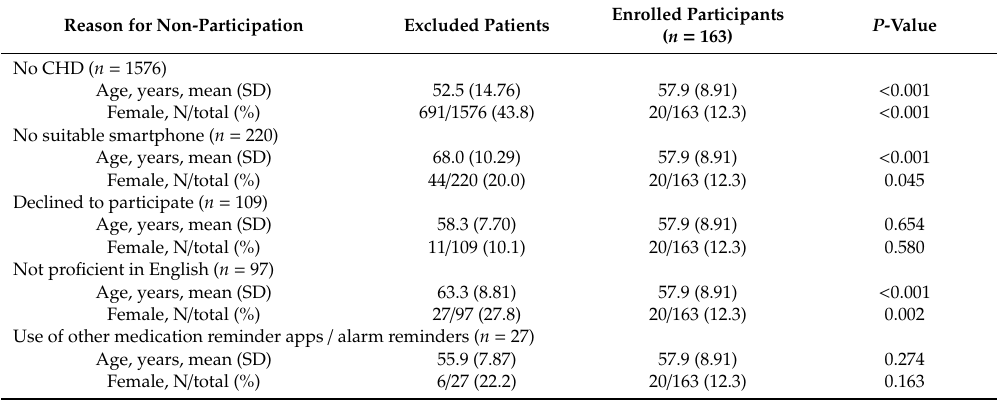
Table 3. Di ff erences between excluded patients and enrolled